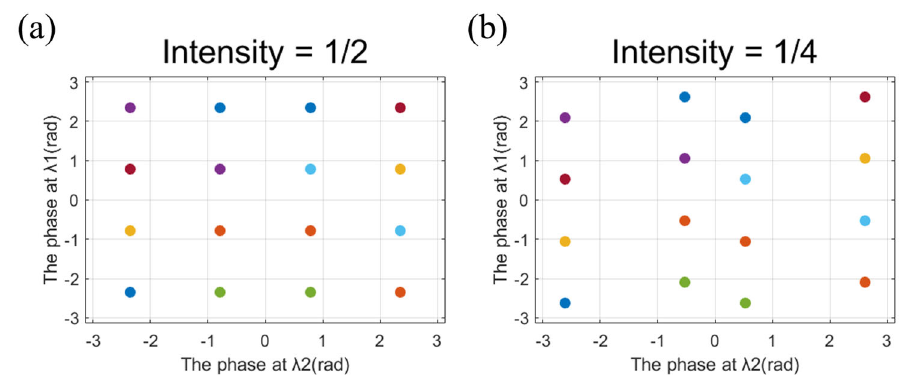
Figure 3. ( a ) The candidate phase distribution in 1/2 intensity. ( b ) The candidate phase distribution in 1/4 intensity.